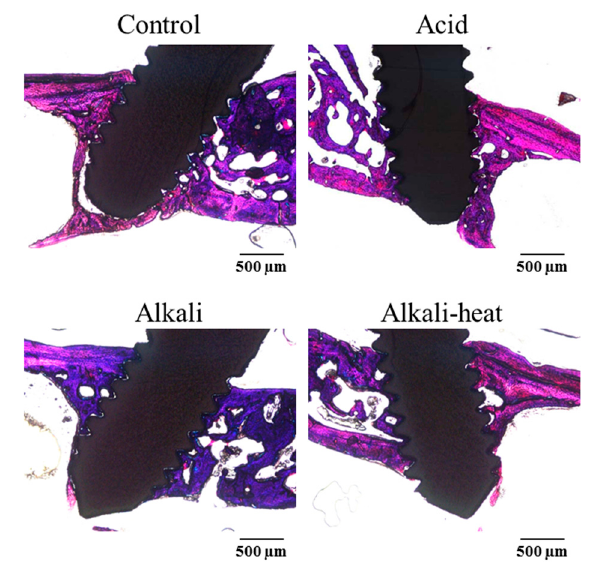
Figure 9. Histological appearances of bone formation around different Ti implants after 6 weeks of implantation.